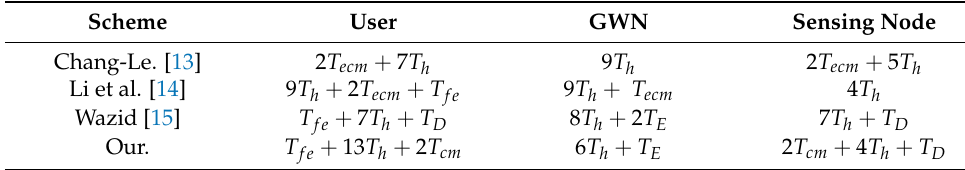
Table 2. Computation costs